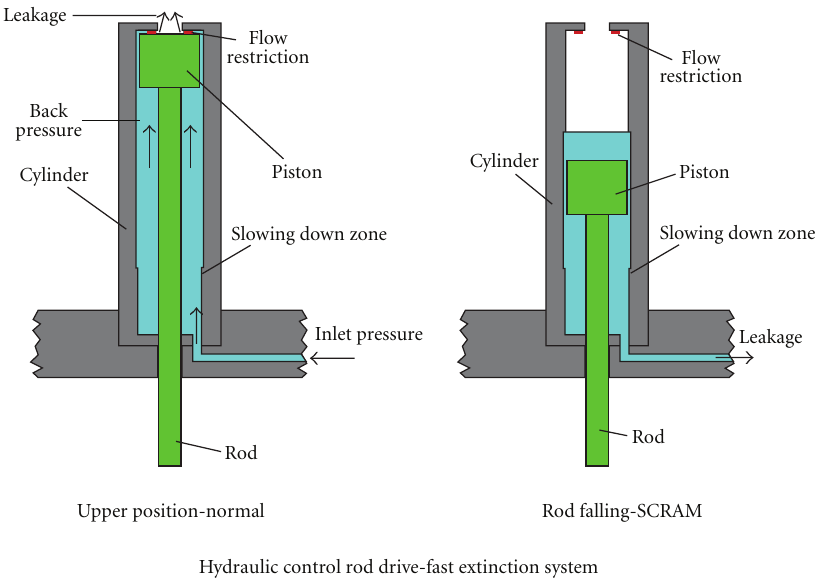
Figure 5: Simplified operating diagram of a hydraulic control rod drive (fast shutdown